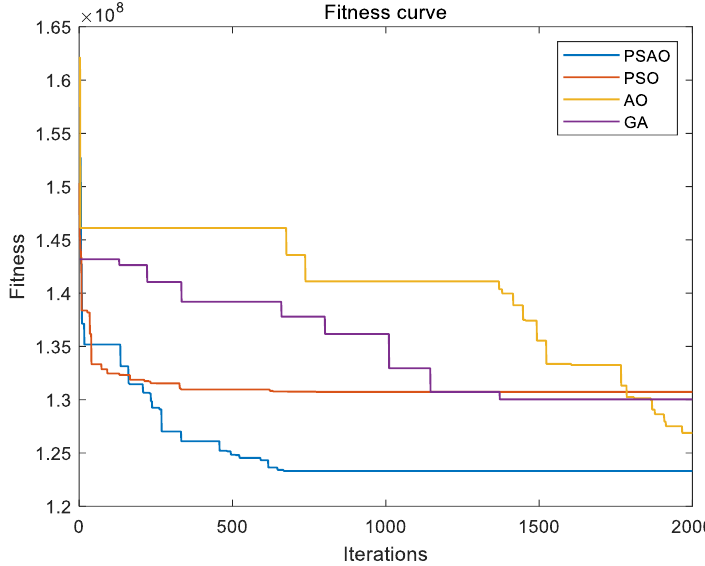
Figure 10. Fitness curve (given substation location).